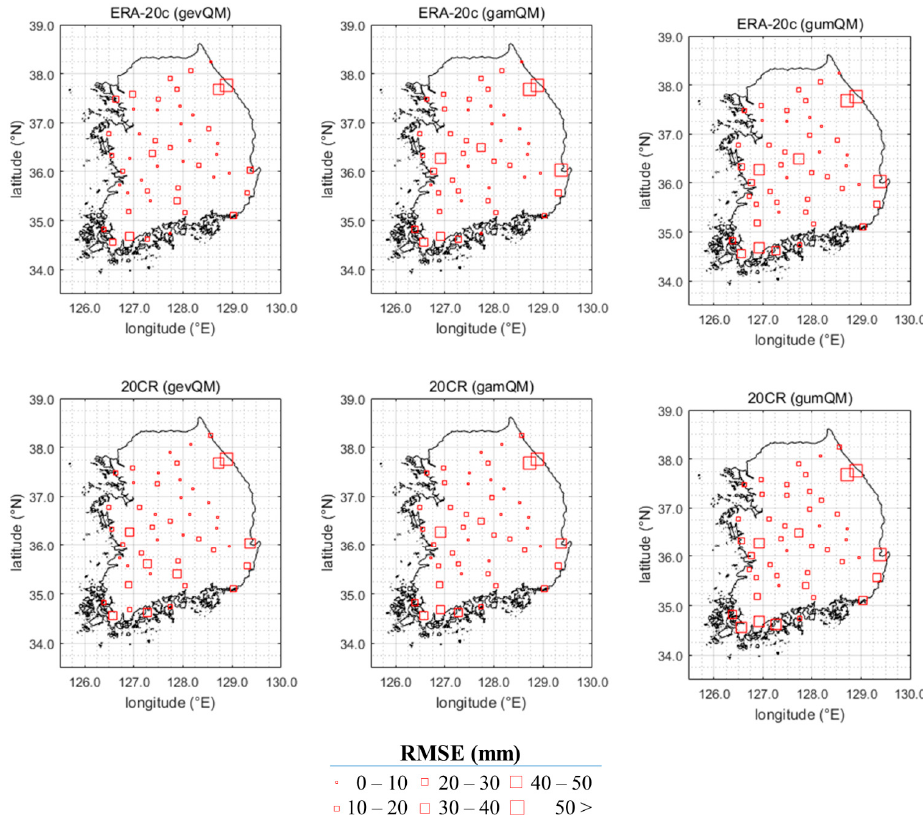
Figure 5. Root mean square error (RMSE) for the AMRs of the bias corrected ERA-20c (above) and 20CR (bottom) by QM approach (gevQM) in 48 stations for the reference period (1974–2010).